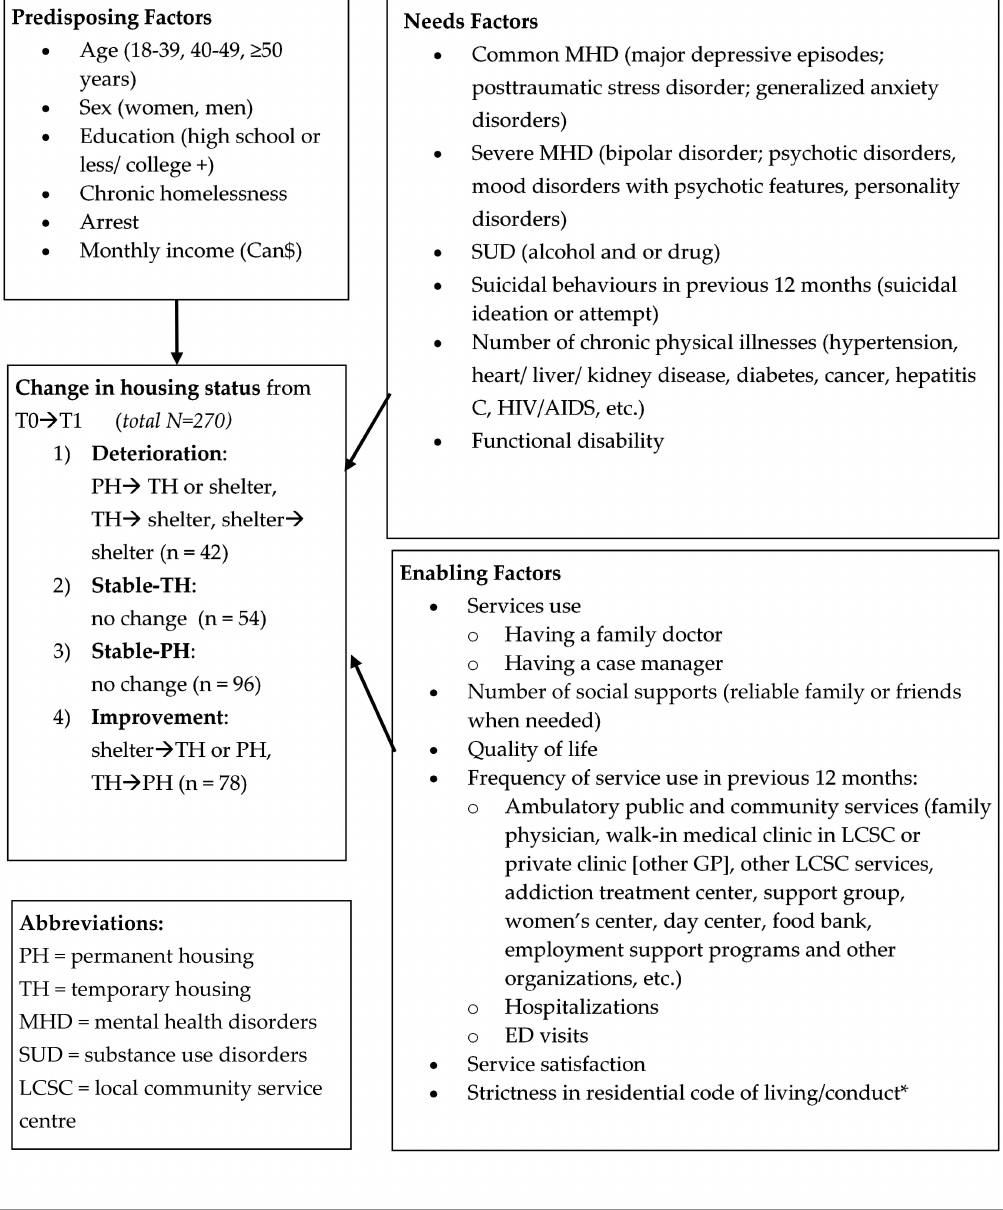
Figure 1. Conceptual framework for change in housing status based on the Gelberg–Andersen Behavioral Model for Vulnerable